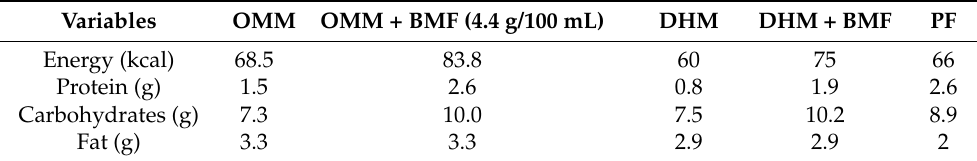
Table 1. Composition of human milk and parenteral feeding per 100